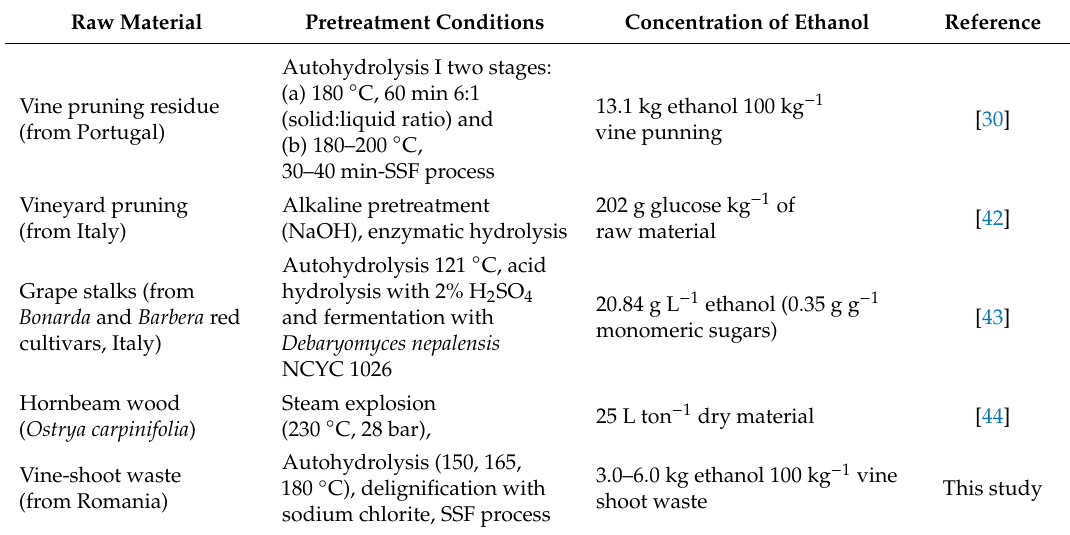
Table 4. Bioethanol concentration obtained in this study and the results reported by literature .